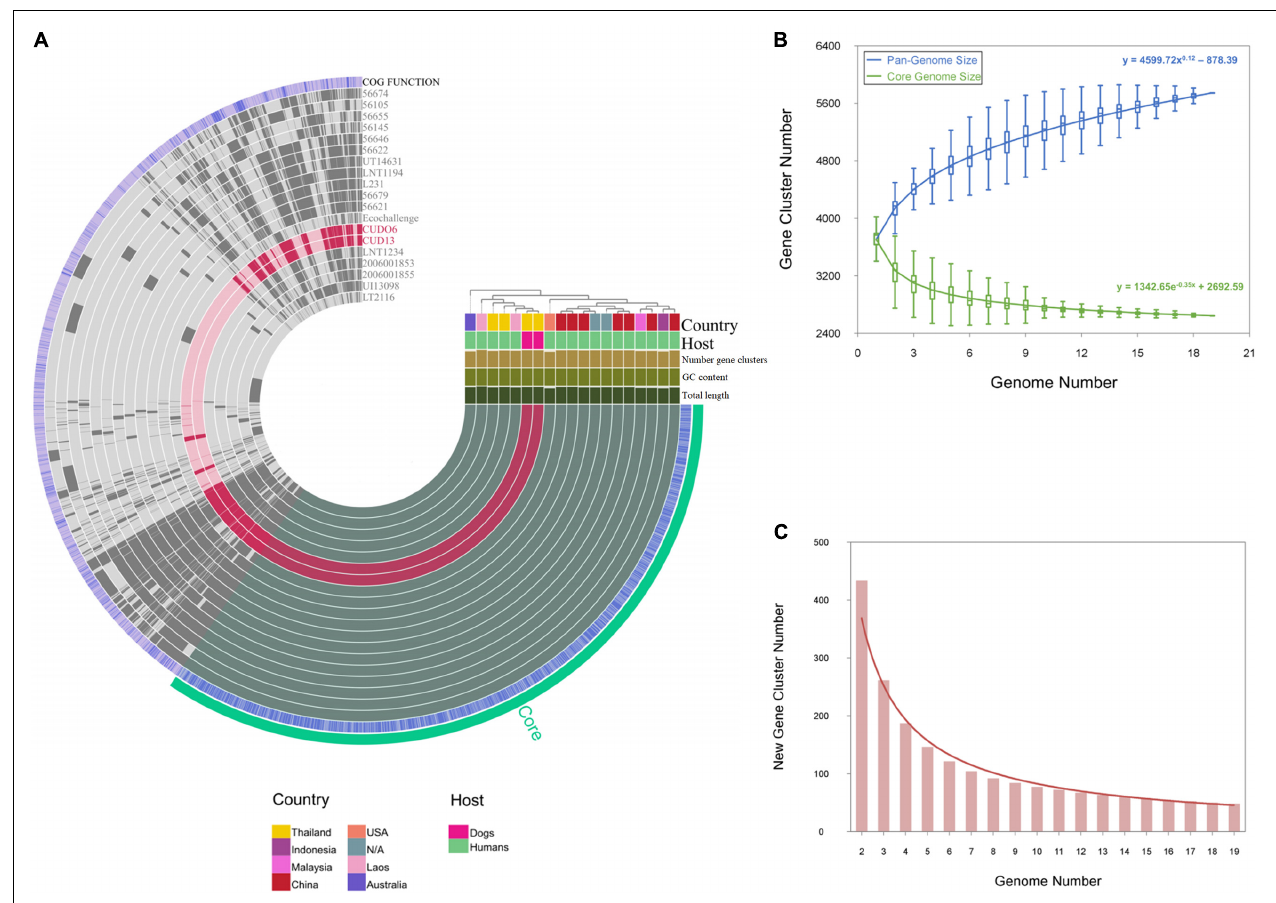
FIGURE 6 | Pan-genome and core-genome analysis of 19 L. weilii strains. The genomes in this figure are ordered according to their phylogenomic analysis based on clustering of the presence and absence gene matrix, which is shown at the right upper of figure. The bars in the 19 first layers represent the gene clusters, as calculated by the Euclidian distances across 19 L. weilii genomes. The next blue layer demonstrates the functional annotation of gene clusters using the EggNOG database, and the last green layer corresponds to core-genome organization (A) . The power-fit and exponential fitting curves with equations of the pan- and core-genomes of the 19 L. weilii are represented by blue and green lines, respectively (B) , while the new gene curve is manifested by a brown line (C)